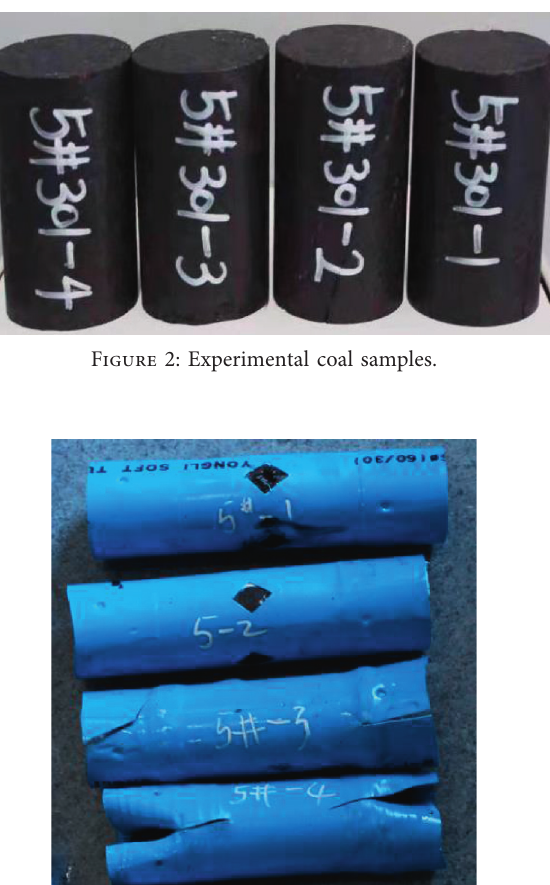
Figure 3: Coal samples after conducting the